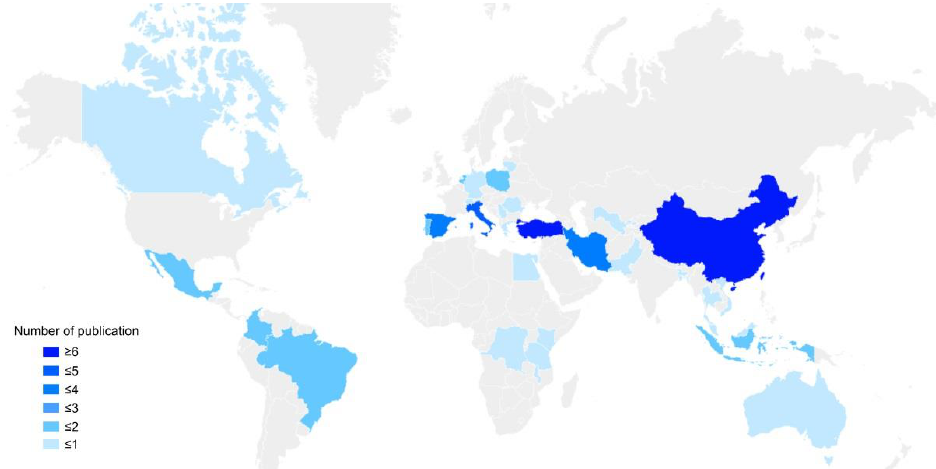
Figure 4. Distribution of publications based on country/area. Table 4. Summary of important authors and institutions in related fields.